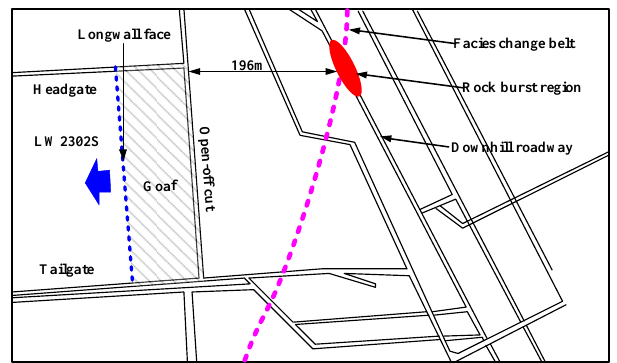
Figure 4. Rock burst region in the LW2302S mining face [24].